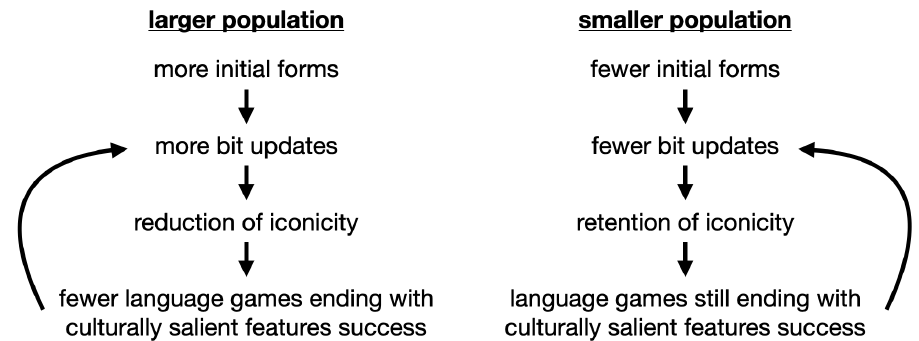
Figure 12. The feedback loop from bit updating to the use of culturally salient features success